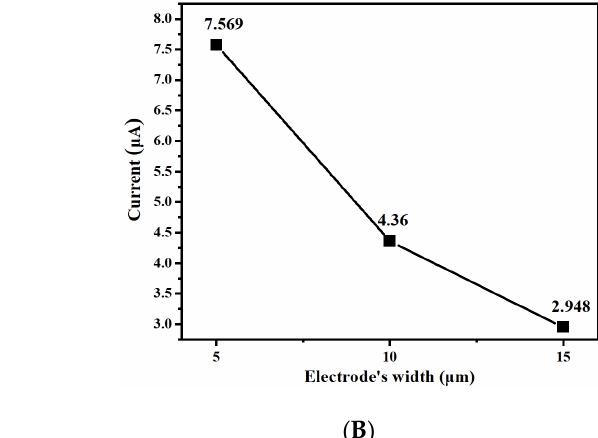
Figure 9. Relationship between response current and ( A ) spacing-to-width ratio; ( B ) width of UIAE.